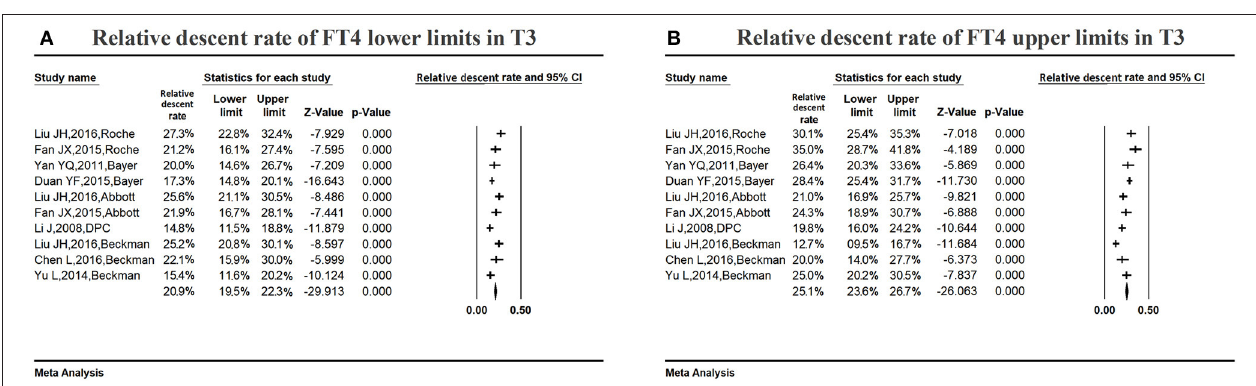
FIGURE 8 | Meta-analysis of relative descent rate of FT4 lower (A) and upper (B) reference limits in late pregnancy. Figure shows unadjusted relative descent rate of FT4 lower (A) and upper (B) limit estimates in late pregnancy with 95% confidence limits for each study selected. Pooled relative descent rate estimates are represented as diamonds in this